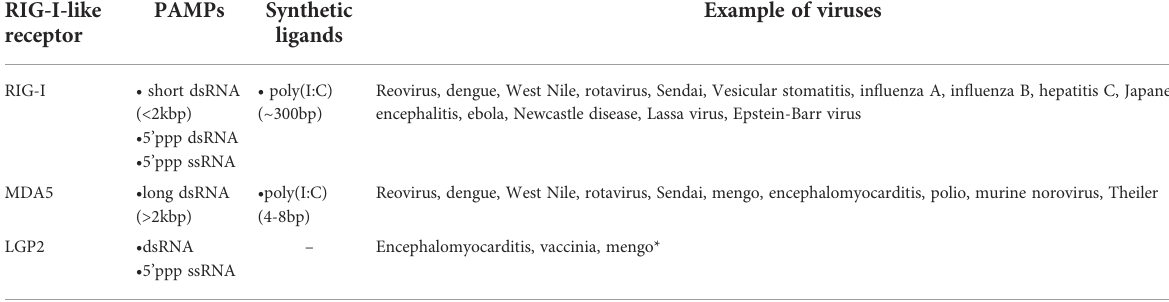
TABLE 1 Ligands and viruses that associate with each RLR.